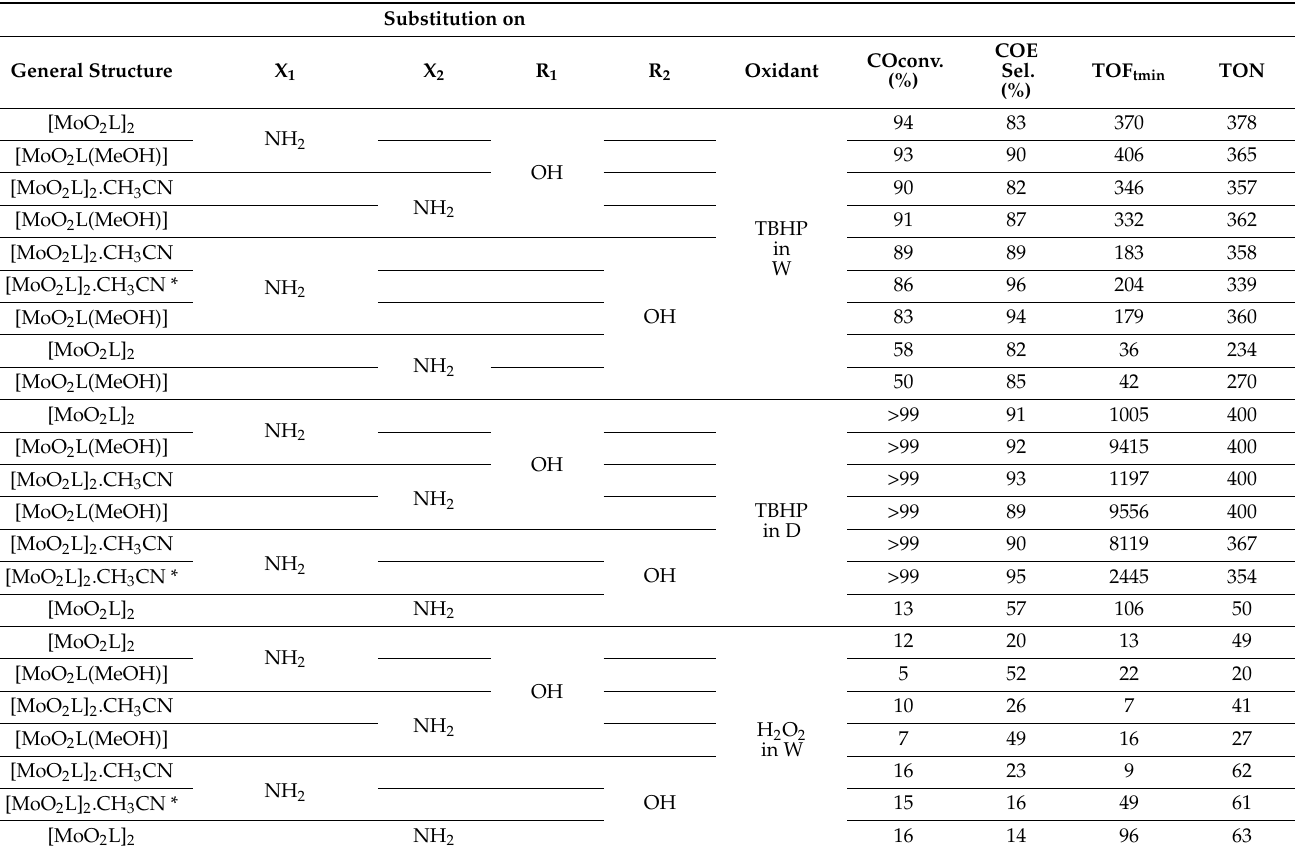
Table 8. Results of CO epoxidation under organic solvent free conditions with MoO 2 L complexes from Figure 11. COE COconv. Sel. Oxidant Substitution on (%)